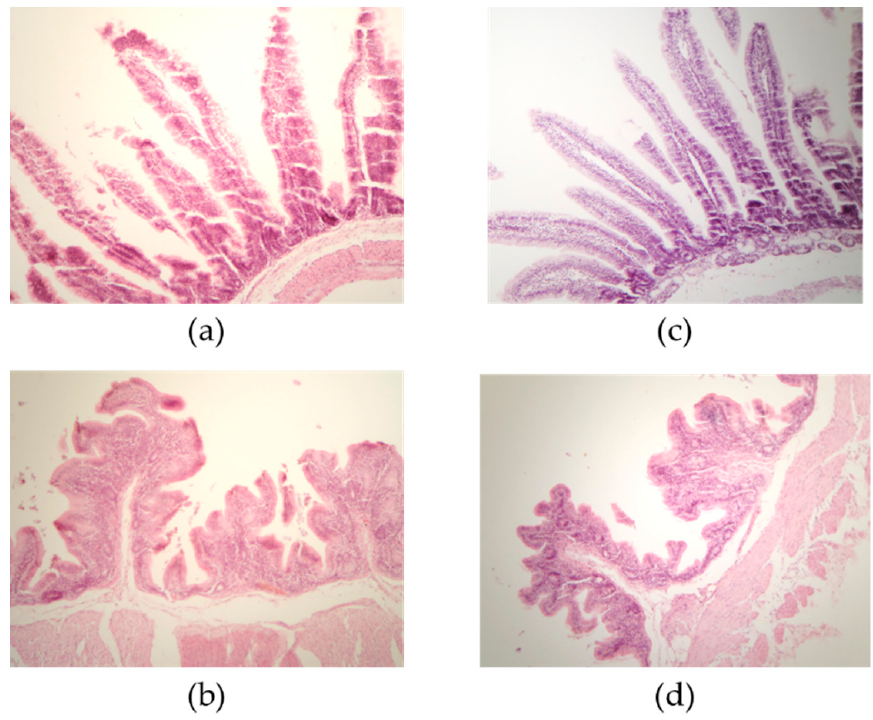
Figure 1. Representative sections. Small intestine of rabbits treated with diet T1 ( a ) and diet T2 ( b ). Caecum of rabbits treated with diet T1 ( c ) and T2 ( d ).